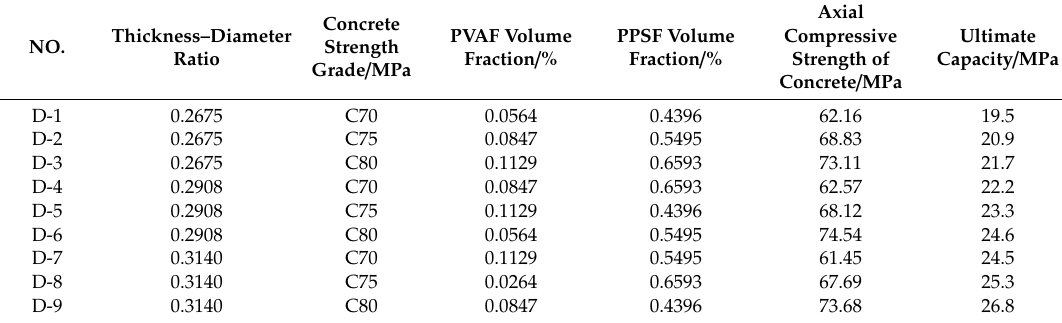
Table 3. The numerical ultimate capacity of shaft lining